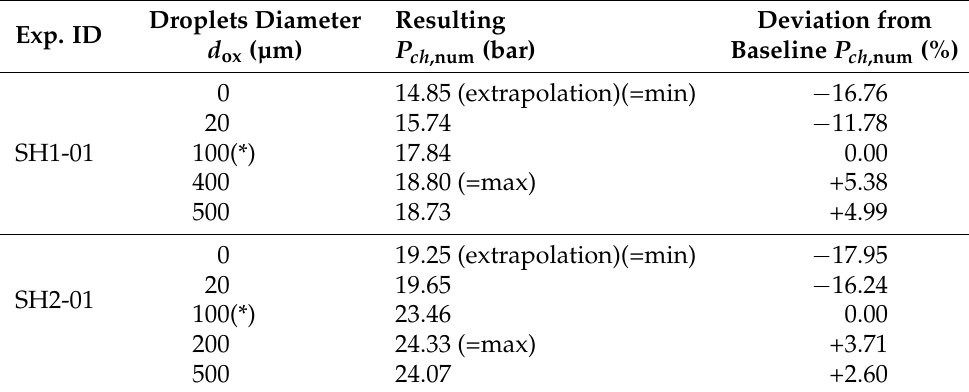
Table 12. Effect on P ch ,num when varying the oxidizer inlet droplets diameter d ox .